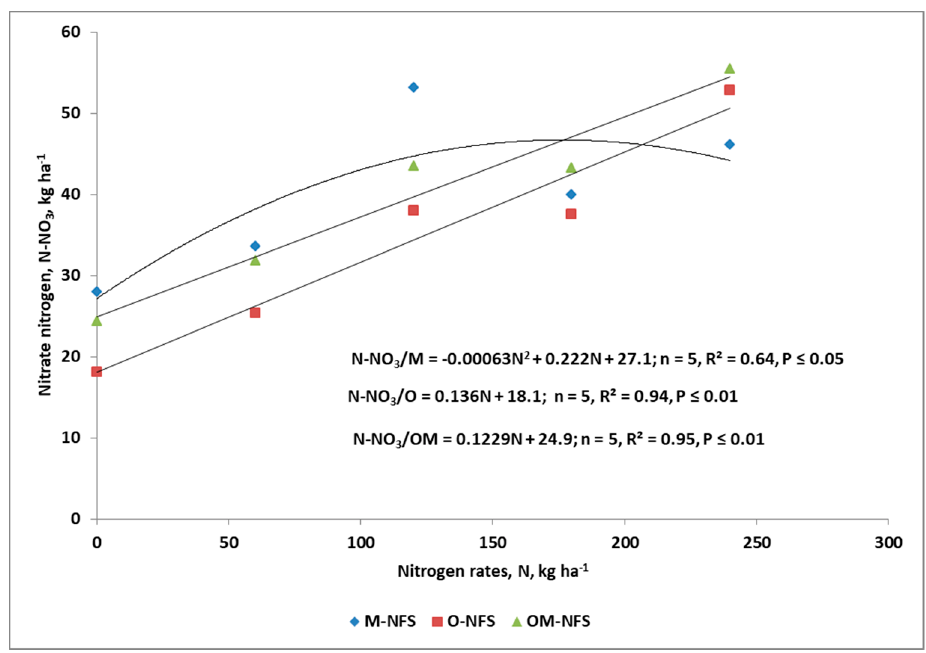
Figure 3. Trends in the N nitrate content at the onset of WOSR flowering for three nitrogen fertilization systems (NFSs). M-NFS, O-NFS, OM-NFS—mineral, organic, organic-mineral NFS,